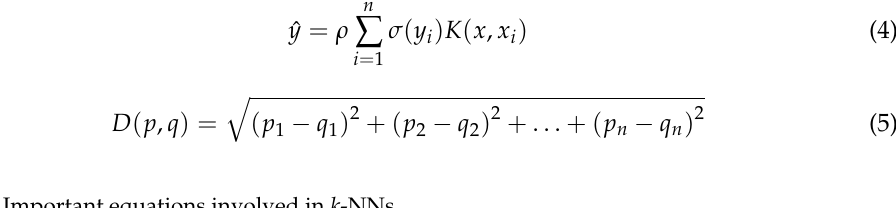
Table 5. Important equations involved in k -NNs.